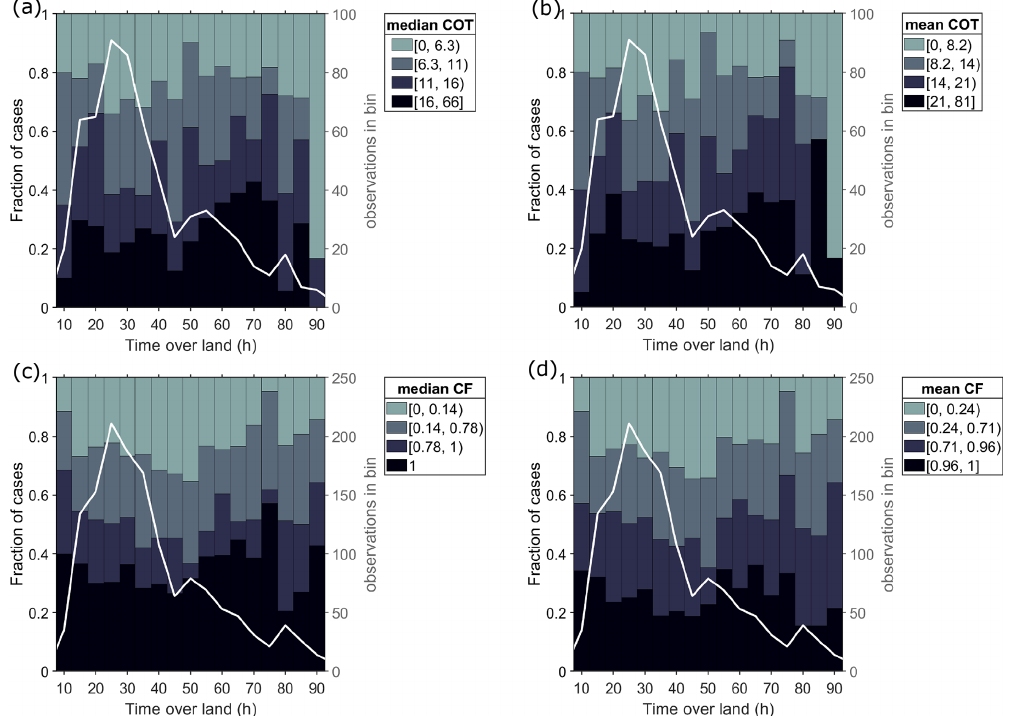
Figure 8. Fractions of satellite-observed 1 ◦ × 0 . 5 ◦ grid (a) median COT, (b) mean COT, (c) median CF, and (d) mean CF in four different value ranges as a function of ToL. The white lines and the right y axes show the number of observations in each bin. The general description of this figure is the same as for Fig. 3. COTs are only considered from satellite views where the number of expected overcast pixels in the 1 ◦ × 0 . 5 ◦ area is at least 20% of the maximum observed. For CF all observations where the partial view over the area is 20% or more are accepted. Note that in panels (a) and (b) the two last ToL bins have only nine and six observations and are therefore very